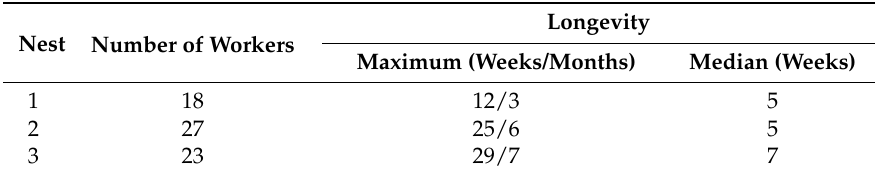
Table 3. Number and maximum and median longevity of workers in three nests of Acromyrmex rugosus rugosus . Room temperature of 24 ± 2 ◦ C and relative humidity of 70% ± 20%. Longevity Nest Number of Workers Maximum (Weeks/Months) Median (Weeks)